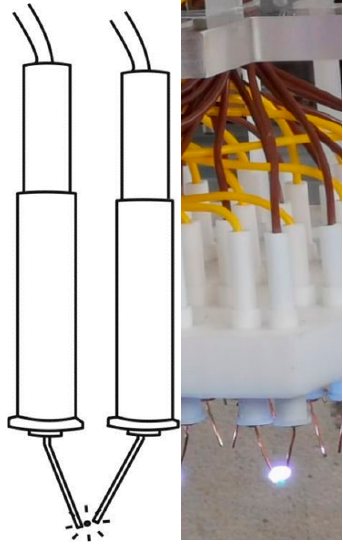
Figure 4. Sparking discharge head, with wires that discharged a high voltage low current, and particles/radical collected in deionized (DI) water.